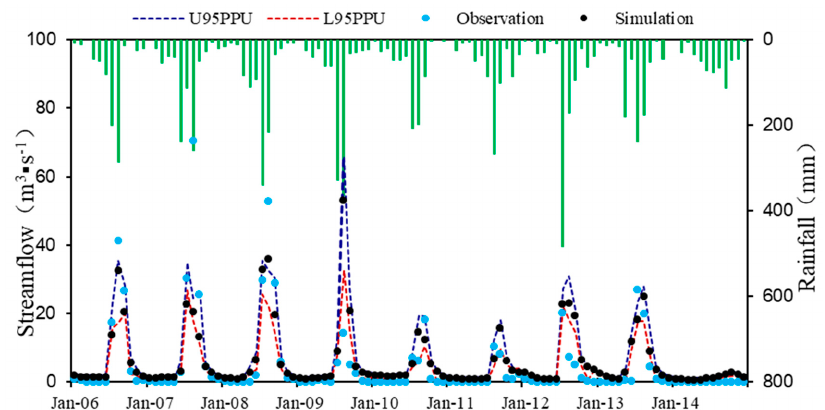
Figure 8. Runoff simulation of the Xinxue River basin in calibration and validation periods 95PPU based on SUFI-2.